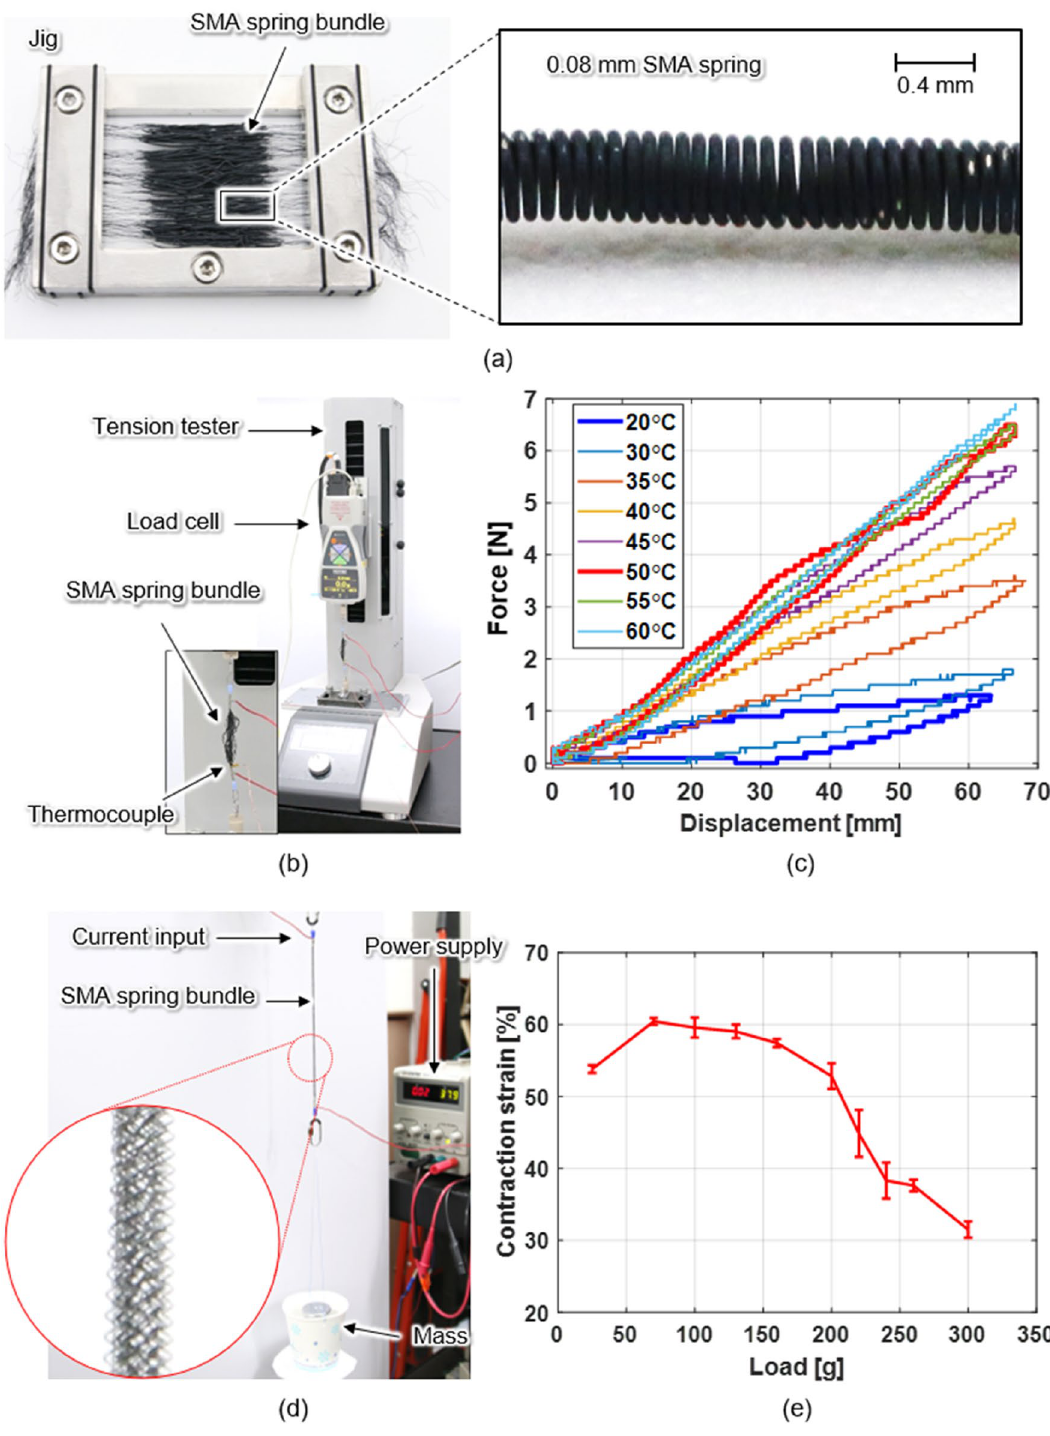
Figure 2. Fabrication and performance evaluation of the SMA spring bundle. ( a ) Aligned SMA springs. ( b ) Experimental setup for isothermal condition tests. ( c ) Isothermal force–displacement curve of SMA spring bundle with respect to heating temperature. ( d ) Experimental setup for measuring the load capacity of SMA spring bundle. ( e ) Relationship between load and contraction strain of the SMA spring